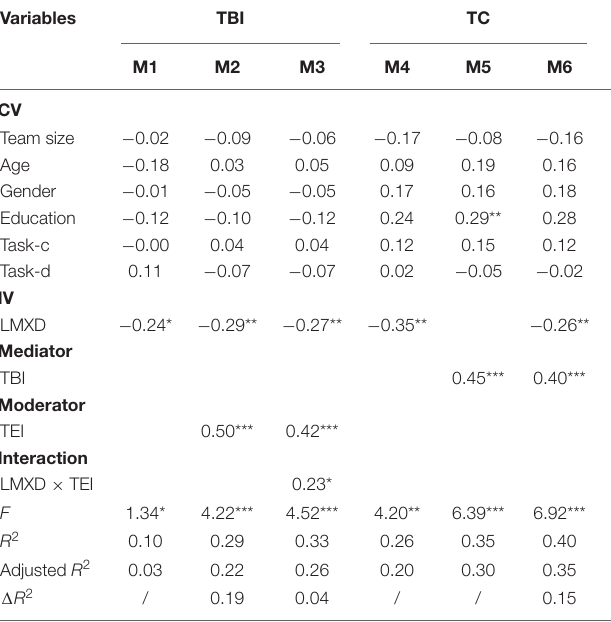
TABLE 3 | Results of mediation and moderation